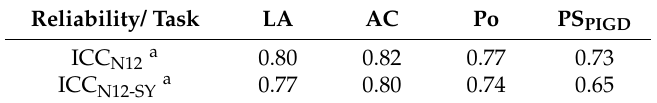
Table 10. Intra Class Correlations for the system and the neurologists assessment